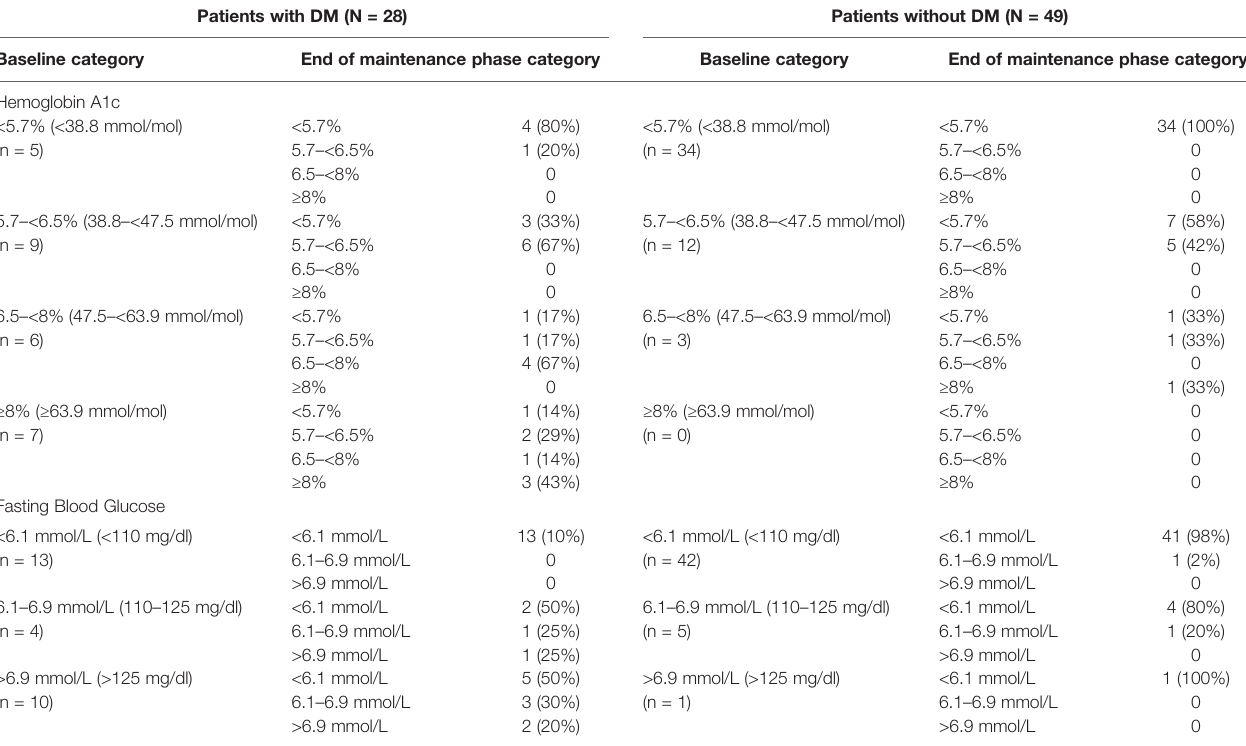
TABLE 2 | Shift from baseline to Month 6 (or last assessed visit in the maintenance phase) in markers of glycemic control (maintenance population). Patients with DM (N = 28) Patients without DM (N = 49) Baseline